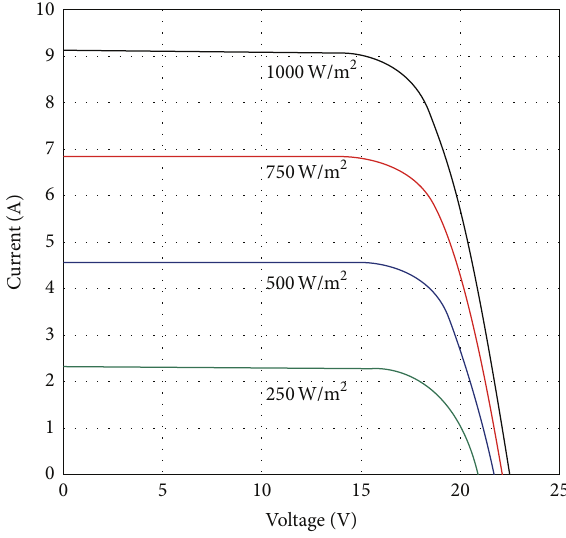
Figure 13: Matlab model 𝐼 - 𝑉 curves for various irradiation levels (BSM-150, 𝐺 = 250, 500, 750, 1000 W/m 2 , 𝑇 = 25 ∘ C).